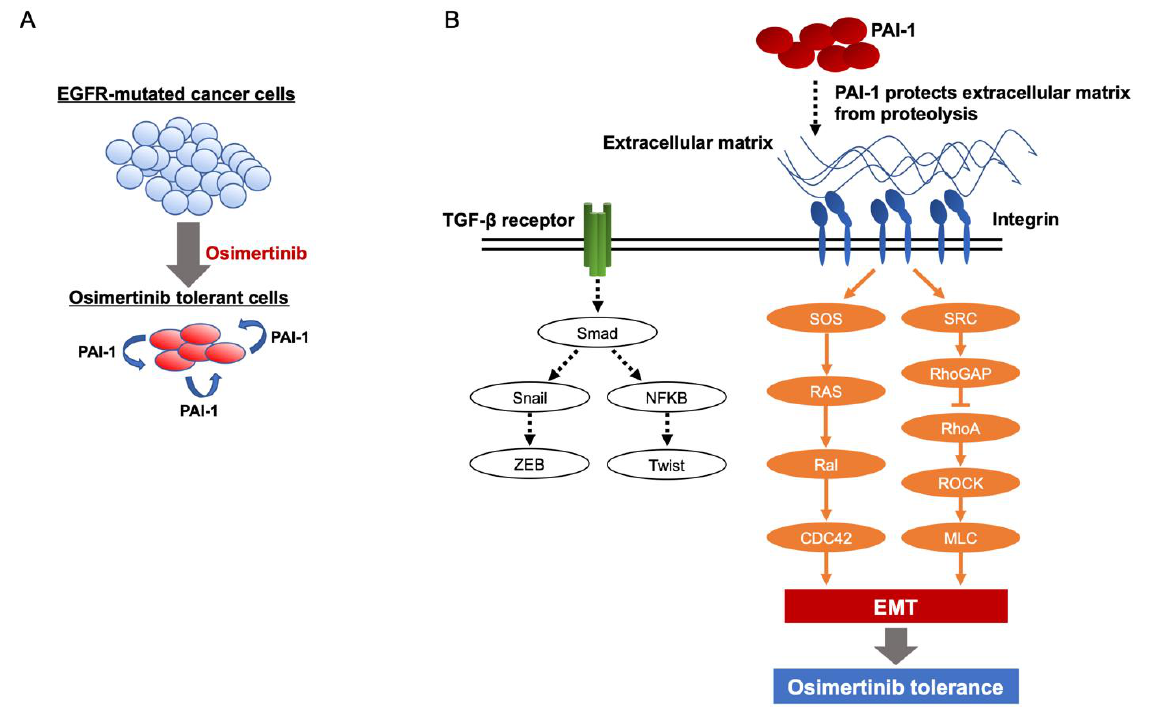
Figure 7. Schematic illustrations of our study. ( A ) The expression of PAI-1 in EGFR-mutated cancer cells increases after tolerance to osimertinib. PAI-1 is involved in tolerance to osimertinib in EGFR-mutated cancer cells. ( B ) PAI-1, which is expressed by osimertinib-tolerant cells, can protect the deposited extracellular matrix (ECM) from proteolysis, resulting in the accumulation of ECM. Subsequently, ECM-to-cell adhesion results in the formation of focal adhesions, which contain integrins. PAI-1 promotes tolerance to osimertinib via integrin- but not TGF- β -mediated EMT signaling pathways.